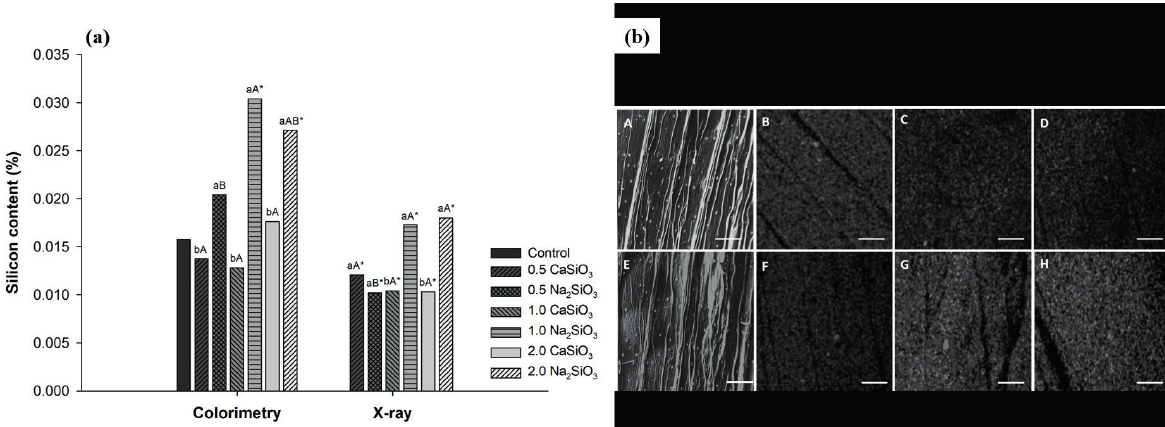
Figure 1 - (a) Silicon content (%) by colorimetric method and X-Ray microanalysis and (b) silicon mapping at the abaxial epidermis in plants of B. zebrina as a function of different sources and concentrations (mg L -1 ) of silicates after 100 days of in vitro growth. (a) means followed by ‘*’ are different from the control by Dunnet’s multiple range test at 5% probability; lowercase letters refer to the unfolding of the sources within each concentration; the means with distinct lowercase letters are different by Tukey’s multiple range test at 5% probability. Capital letters refer to the unfolding of concentrations within each source; the means with distinct capital letters are different by Tukey’s multiple range test at 5% probability. (b ): (A) control; (B) 0.5 mg L -1 CaSiO ; (C) 1 3 mg L -1 CaSiO ; (D) 2 mg L -1 CaSiO ; (E) control; (F) 0.5 mg L -1 Na SiO ; (G) 1 mg L -1 Na SiO ; (H) 2 mg L -1 Na SiO . Bar 100 3 3 2 3 2 3 2 3